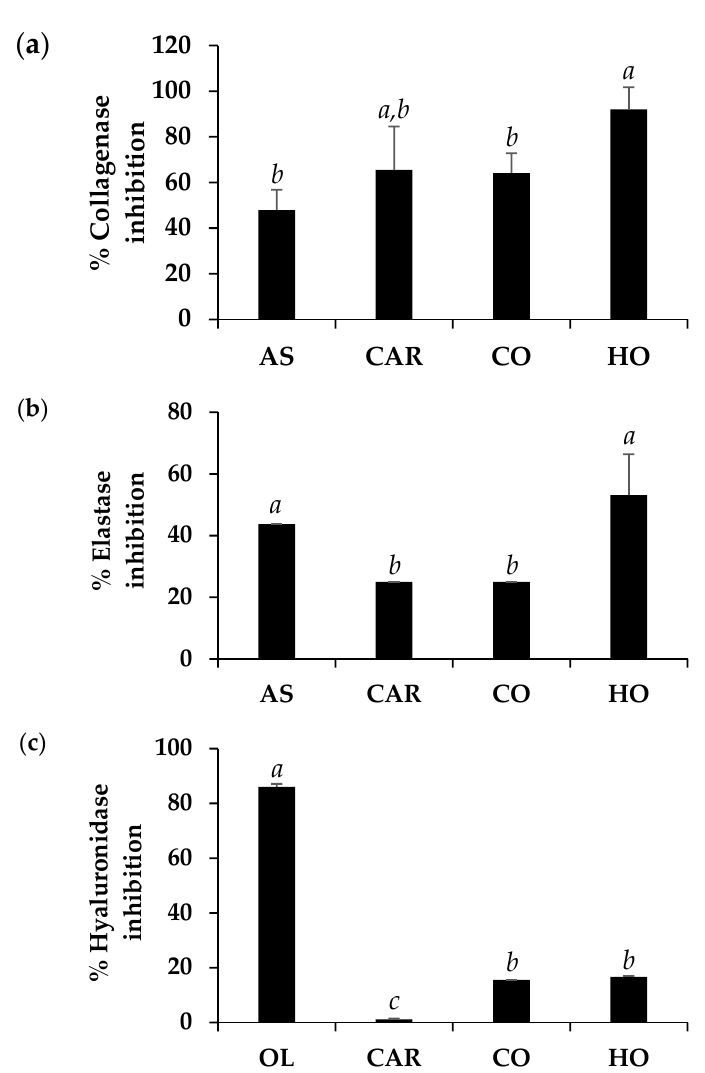
Figure 4. Inhibitory activity against collagenase ( a ), elastase ( b ), and hyaluronidase ( c ) of ascorbic acid (AS), oleanolic acid (OL), carvacrol (CAR), and commercial O. vulgare essential oil from Mediterranean region (CO), and highland O. vulgare essential oil from tropical region (HO). The letters, a, b, and c denoted significantly different anti-skin-ageing activity among different tested compounds ( P < 0.05).